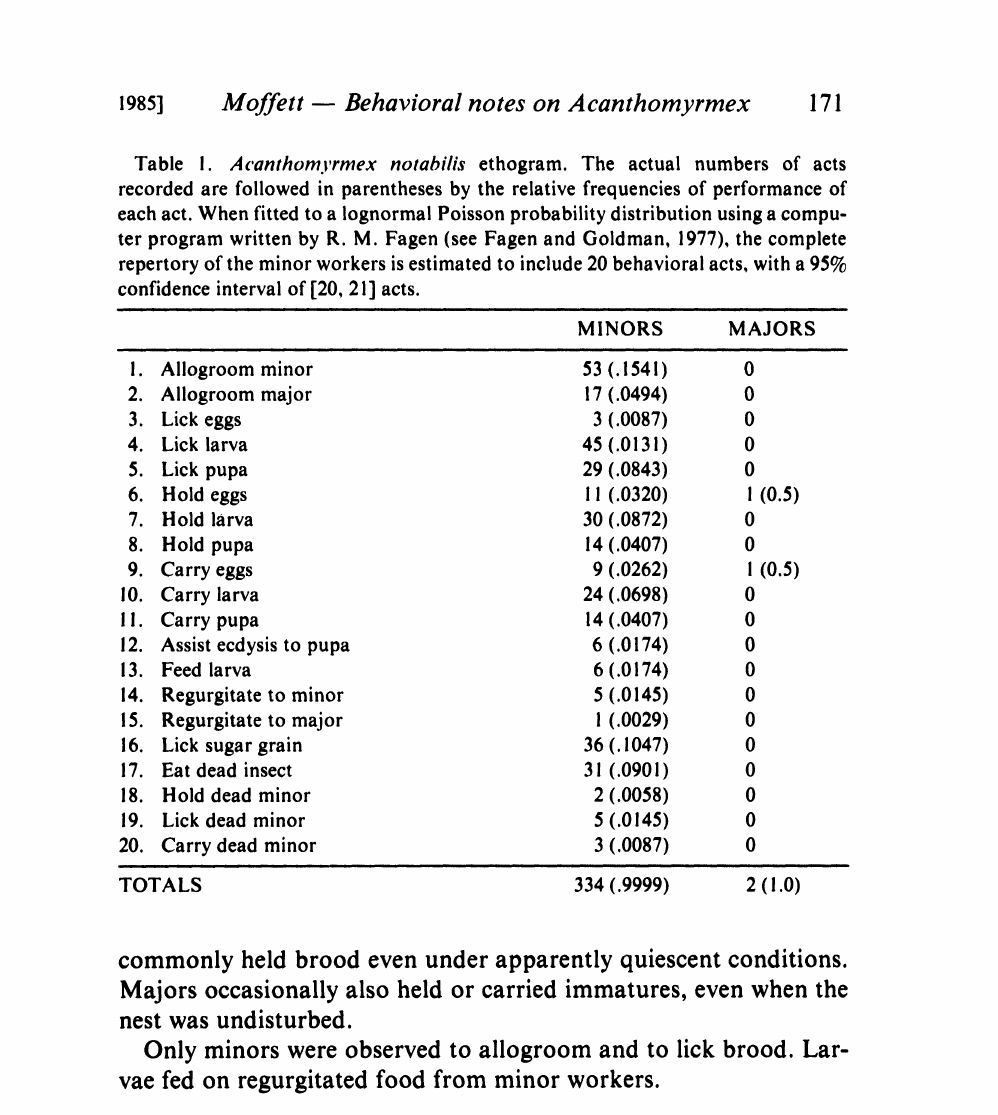
Table I. Acanthomyrmex notabilis ethogram. The actual numbers of acts recorded are followed in parentheses by the relative frequencies of performance of each act. When fitted to a Iognormal Poisson probability distribution using a compu- ter program written by R. M. Fagen (see Fagen and Goldman, 1977), the complete repertory of the minor workers is estimated to include 20 behavioral acts, with a 95% confidence interval of [20, 2 I]